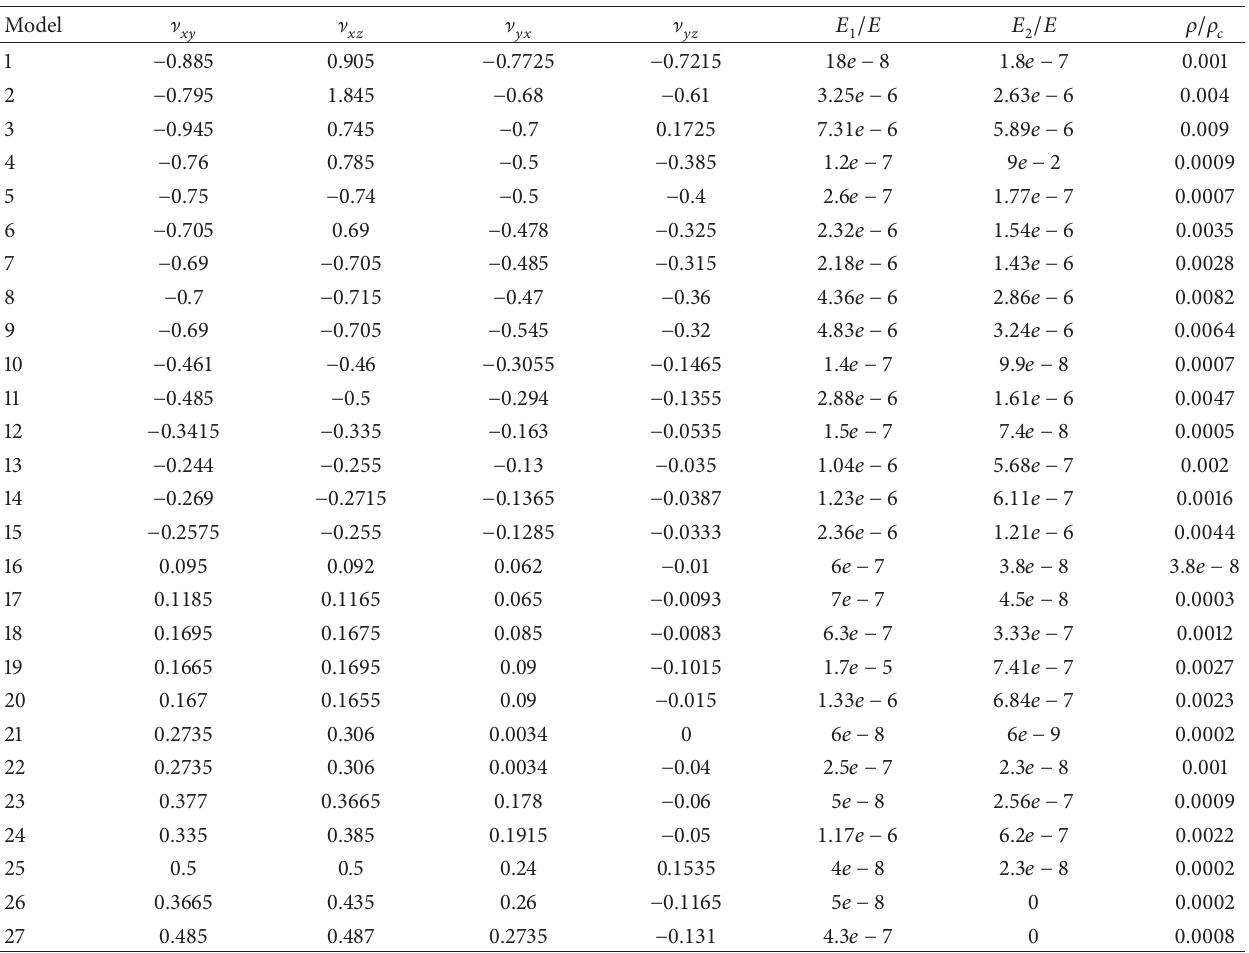
Table 2: Finite element results of Poisson’s ratios, elastic modulus, and density ratio of